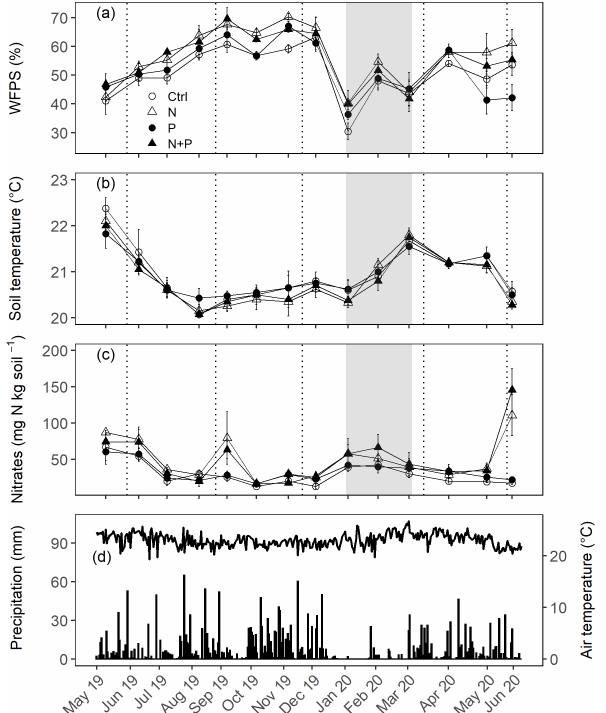
Figure 3. Mean ( ± SE; n = 4) soil CO 2 fluxes (a) , CH 4 fluxes (b) , and N 2 O fluxes (c) measured monthly (between May 2019 and June 2020) from control (Ctrl), nitrogen (N), phosphorus (P), and N + P plots of the nutrient manipulation experiment. Vertical lines indicate the timing of each split dose of N (31.3kgNha − 1 ), P (12.5kgPha − 1 ) and N (31.3kgNha − 1 ) + P (12.5kgPha − 1 ) fer- tilization every 3 months. The gray shaded rectangle marks the be- ginning and end of the dry season (January and February; monthly precipitation < 100mm). Note: transitory N 2 O fluxes (measured within 28d from fertilization) from N addition plots (N and N + P) were detrended to compensate for absence of frequent measure- ments immediately after fertilization coming from sampling GHGs